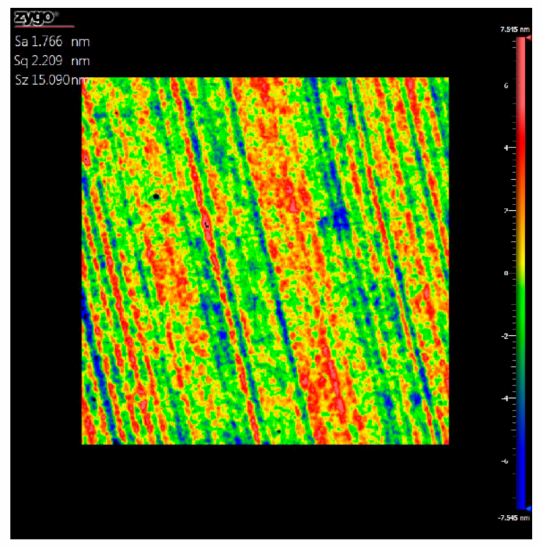
Figure 17. Roughness testing results using white light interferometry.